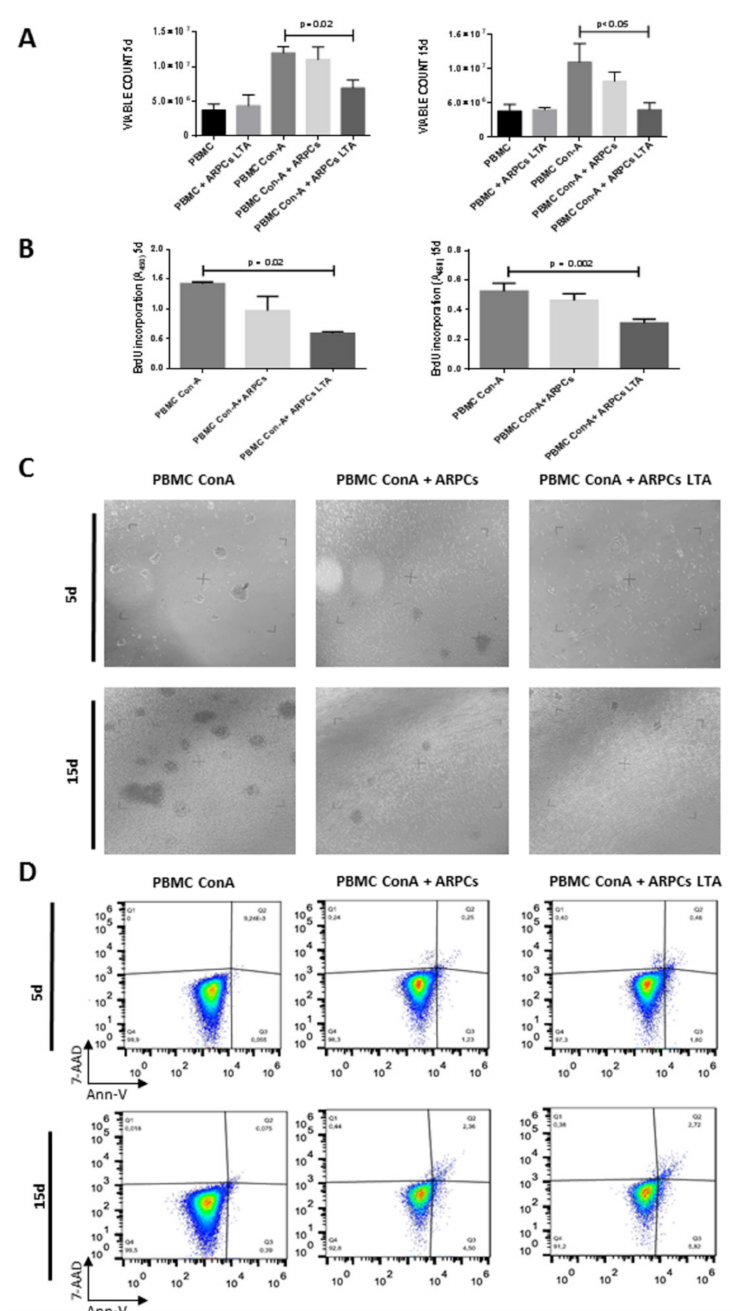
Figure 1. TLR2-activated- Adult Renal Stem/Progenitor Cells (ARPCs) were able to decrease Peripheral blood mononuclear cell (PBMC) proliferation. ( A ) TLR2-activated-ARPCs were able to decrease the viable count of Con-A activated PBMCs in an independent set of 3 experiments with 3 ARPC clones and PBMC from 3 different healthy donors after both 5 days and 15 days of co-culture. Data from 15 days of co-culture were normalized to 5 days of co-culture in order to compare differences in viable counts. ( B ) BrdU assays showed that LTA-stimulated ARPCs decreased PBMCs’ proliferation rate both after the 5th and 15th day of co-culture. The histograms represent the mean ± SEM. ( C ) PBMCs’ morphology was examined under a light-inverted microscope. Con-A activated PBMCs’ morphology was observed after 5 and 15 days of culture in different conditions. Con-A activated PBMCs formed rounded cellular aggregate after 5 and 15 days of culture in response to the Con-A mitogen effect. When Con-A activated PBMC were co-cultured with ARPCs or LTA-activated ARPCs, a lower number of cellular aggregates was observed both after 5 and 15 days. PBMC images were acquired by an upright microscope with a 10 × objective. ( D ) Comparative analysis of apoptosis in Con-A activated PBMCs revealed no significant increase in early and late apoptosis or necrosis when cells were co-cultured with ARPCs and LTA-activated ARPCs after 5 days of co-culture. After 15 days of co-culture, early and late apoptosis increased slightly. Results are representative of 3 independent experiments on 3 different cell